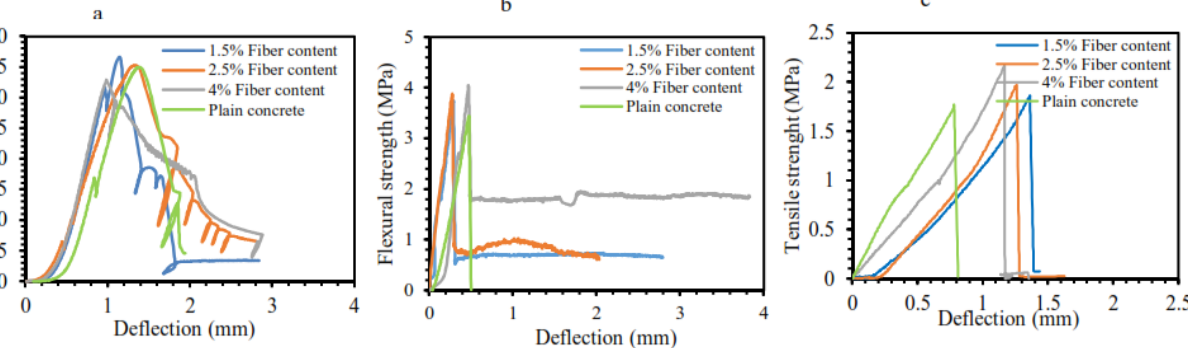
Figure 10: Results obtained from the tests at different proportions of polymer fiber amount a. compressive test b. flexural test c. direct tensile